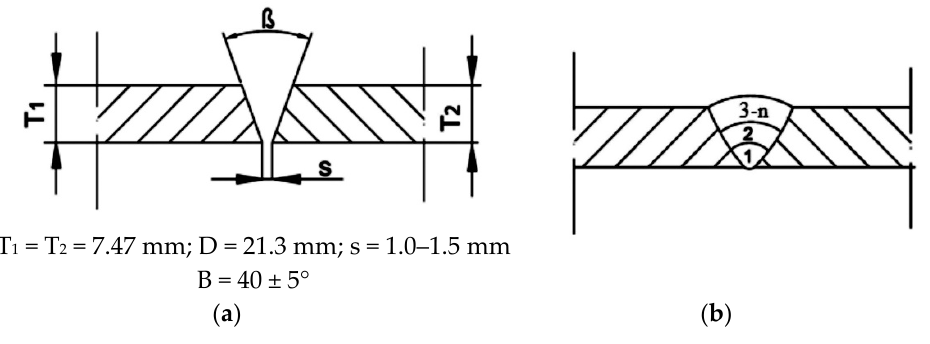
Figure 1. Scheme of ( a ) edge preparation for welding, ( b ) welding sequence.